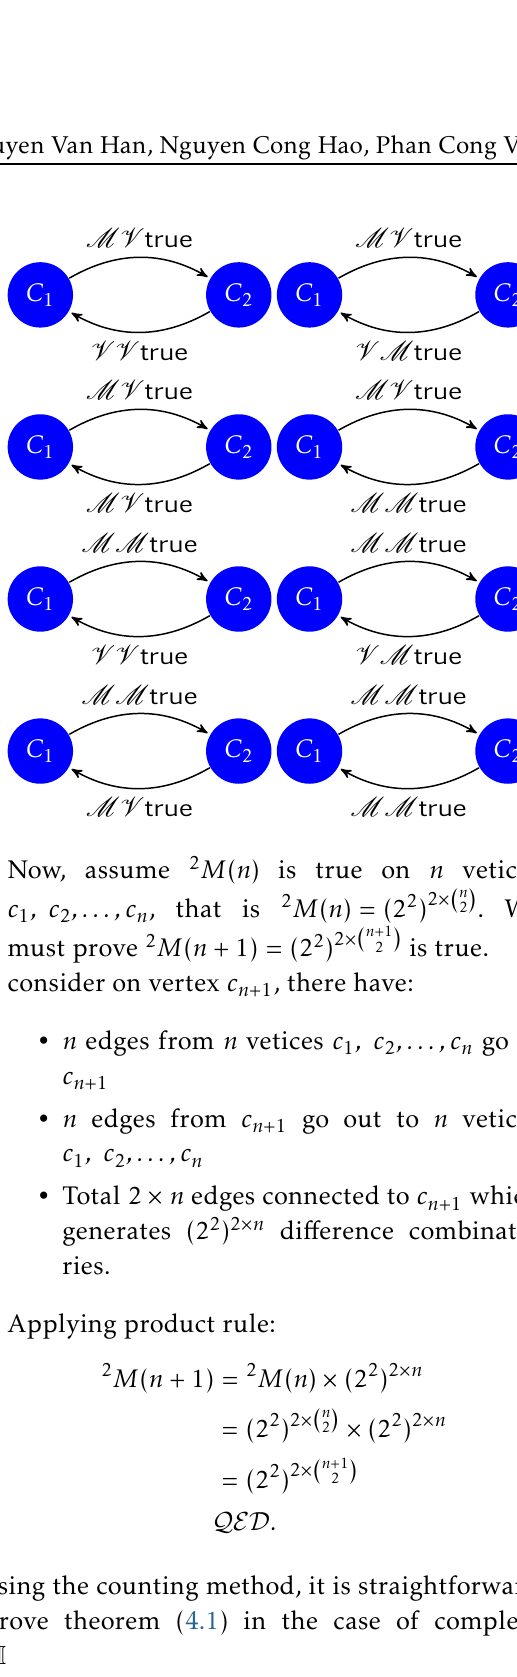
For Fig. 4, square matrix: